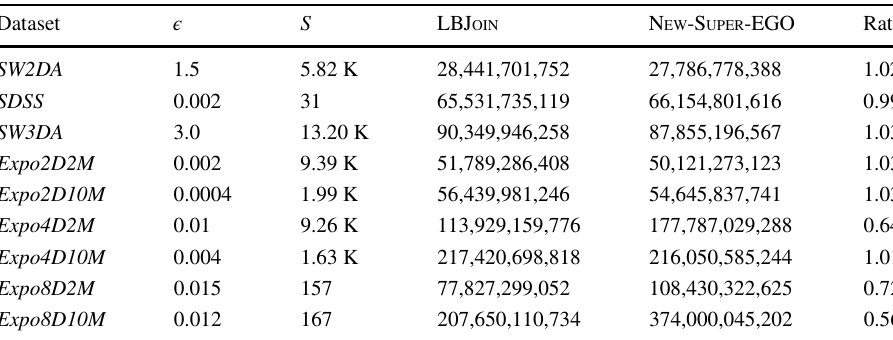
Results from Platform